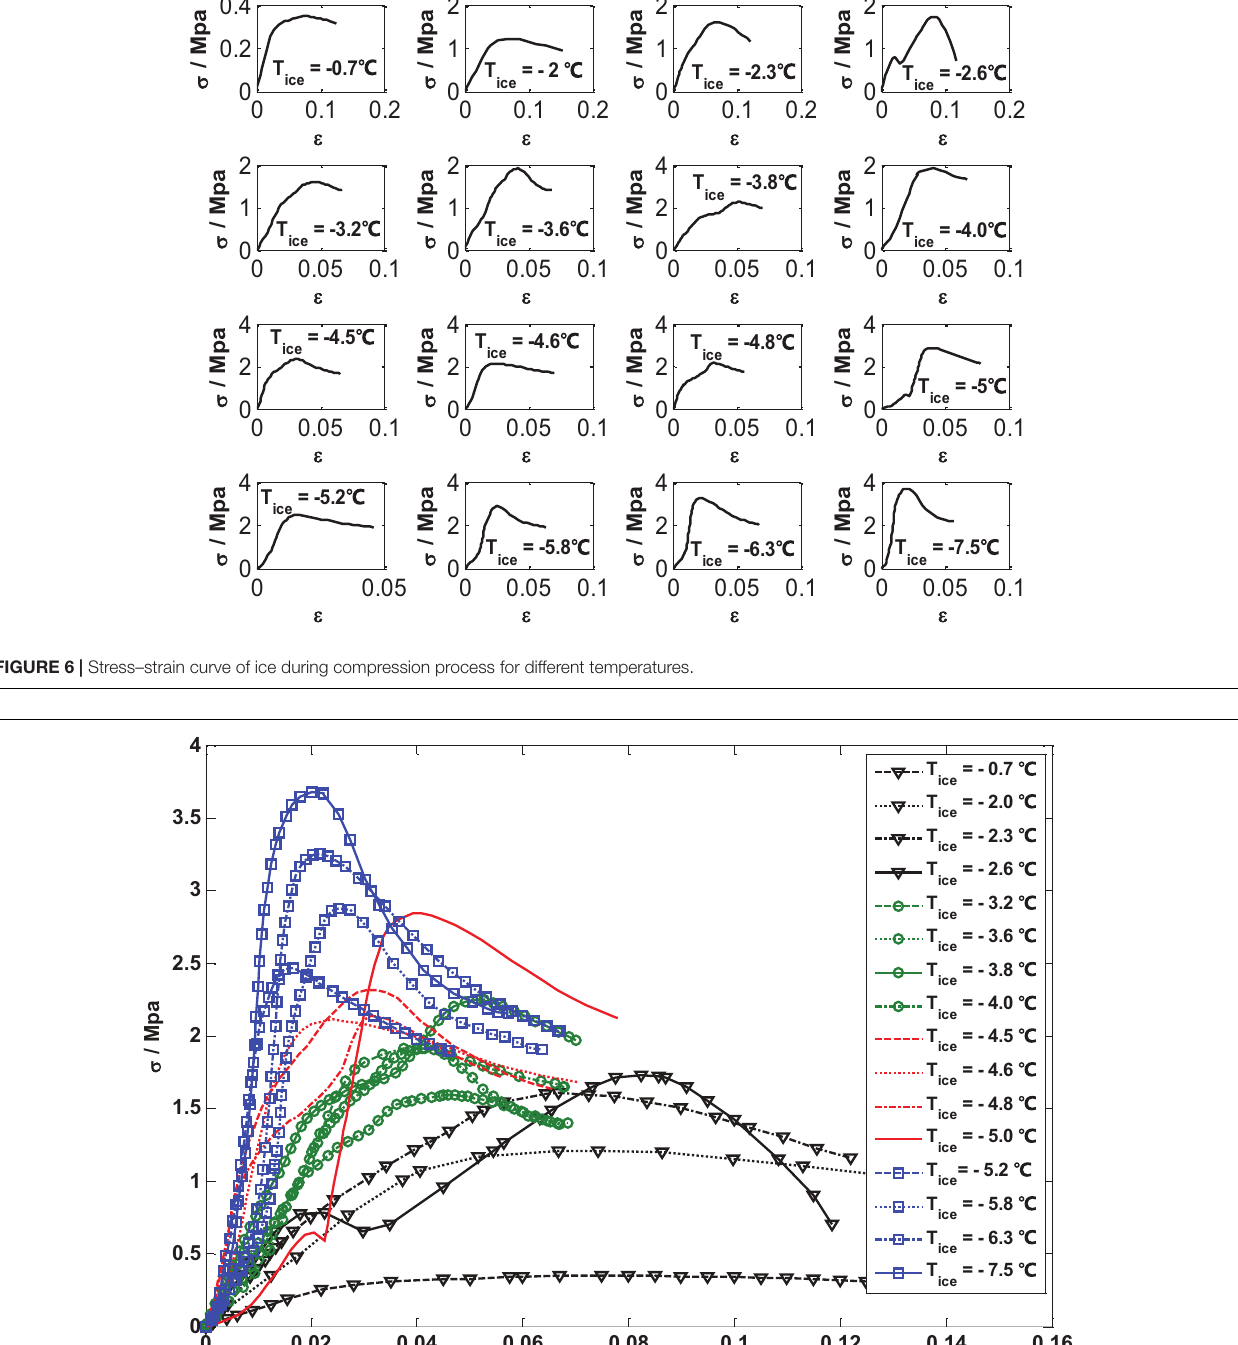
different ice temperatures, and the stress–strain curves are also obtained, which are shown in Figures 6 , 7 . The peak value of stress is the compressive strength and the gradient of the linear segment in the stress–stain curve is compressive modulus.